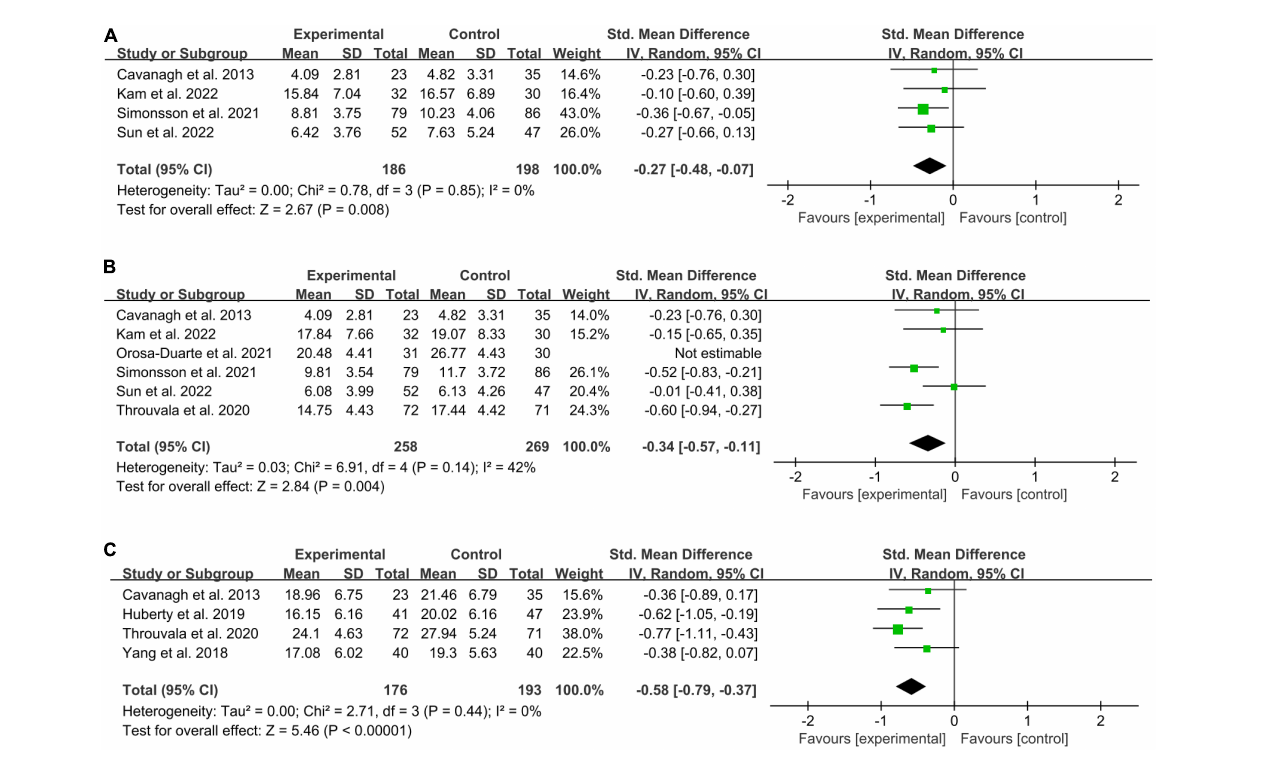
FIGURE3 Forest plot of meta-analysis for the efficacy of online MBIs on mental health. (A) Depression. (B) Anxiety. (C) Stress.